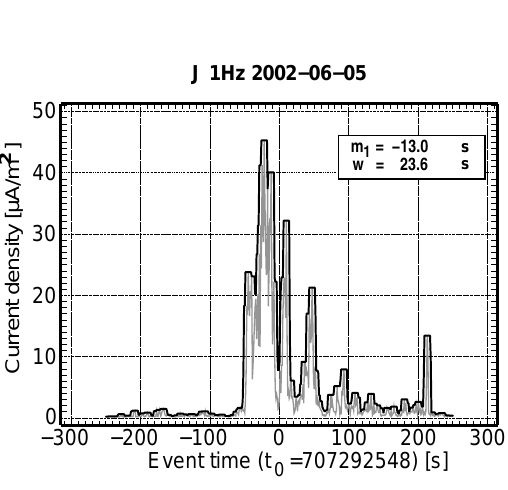
Fig. 2. Example of KSFAC burst event (left) and enlarged detail at 50-Hz resolution (right).